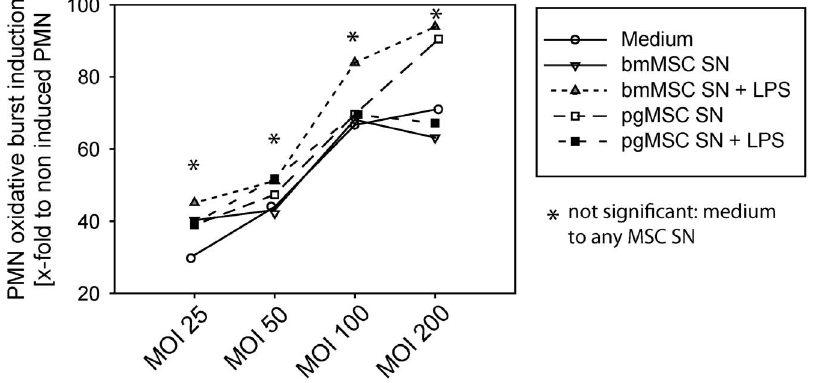
Figure 8. Respiratory Burst. PMNs were pre-incubated in bmMSCs or pgMSCs supernatant or standard culture medium (1 h). PMNs were incubated in the presence or absence of Escherischia coli with MOI 25, 50, 100, and 200, followed by addition of dihydrorhodamine-123. Superoxide anion (O 2 2 ) release was measured by flow cytometry. Each panel of the figure shows the mean of 3 independent experiments.